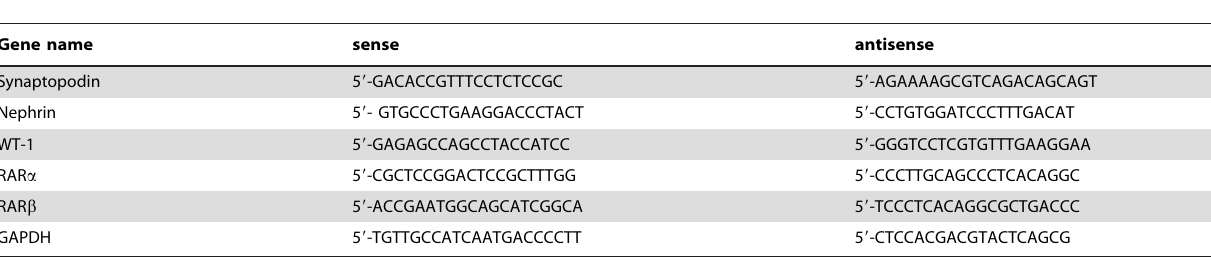
Table 2. Sequences of the